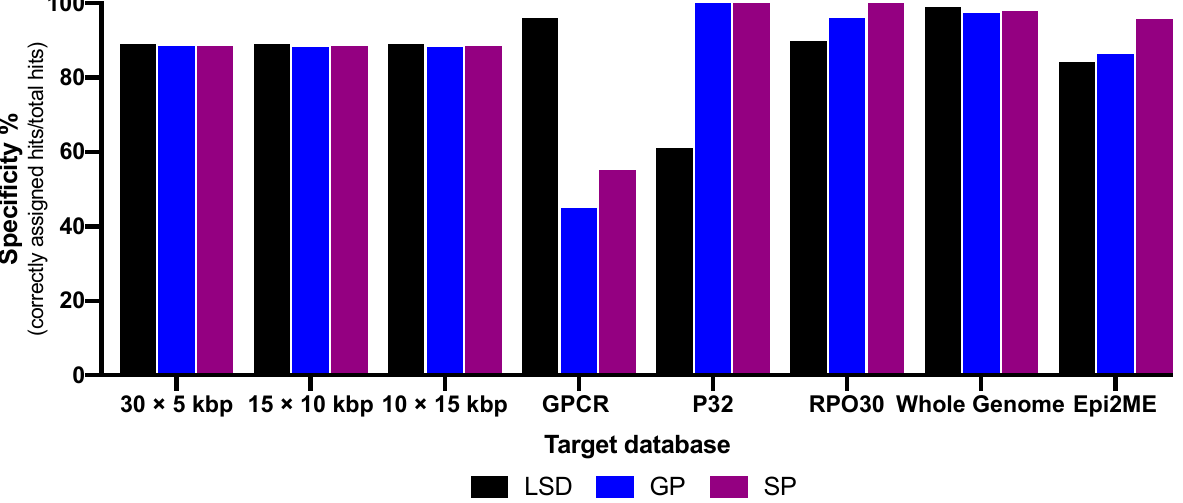
Figure 2. Average specificities of various offline Basic Local Alignment Search Tool (BLAST) and online EPI2ME databases.